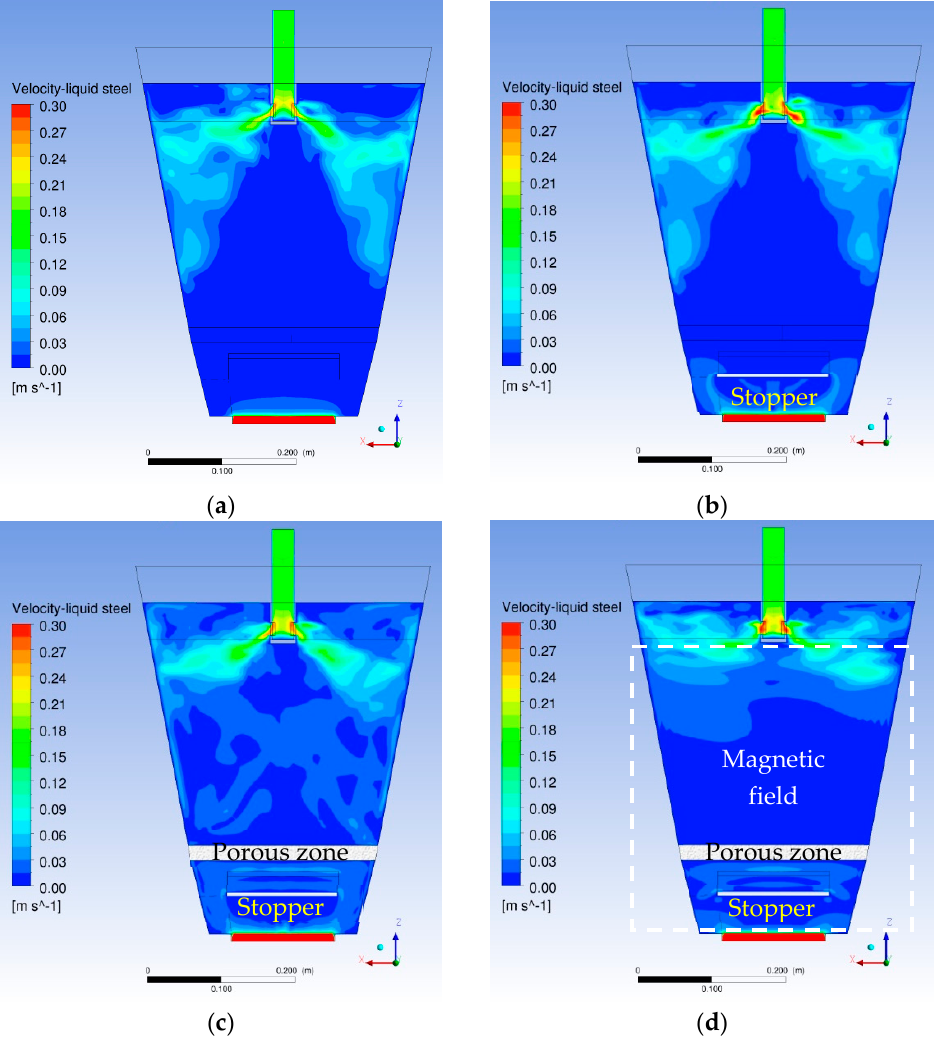
Figure 5. Flow field predicted by the mathematical modeling using various experimental facilities. ( a ) Without the facilities, ( b ) with the stopper, ( c ) with the stopper and porous baffle, ( d ) with the stopper, porous baffle, and magnetic field.